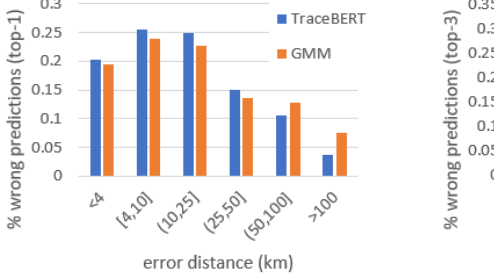
Figure 4. Bar graphs reporting the error distance distribution of the masked locations that are wrongly predicted by both TraceBERT and GMM (from left to right : wrong predictions in top-1, top-3, and top-5, respectively).